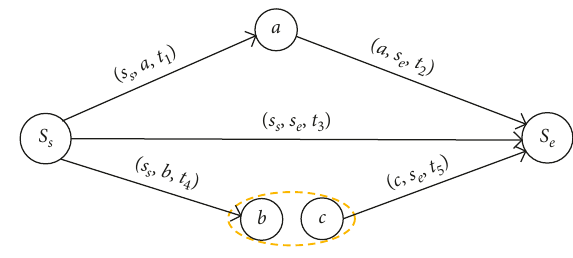
Figure 6: Passenger travel routes